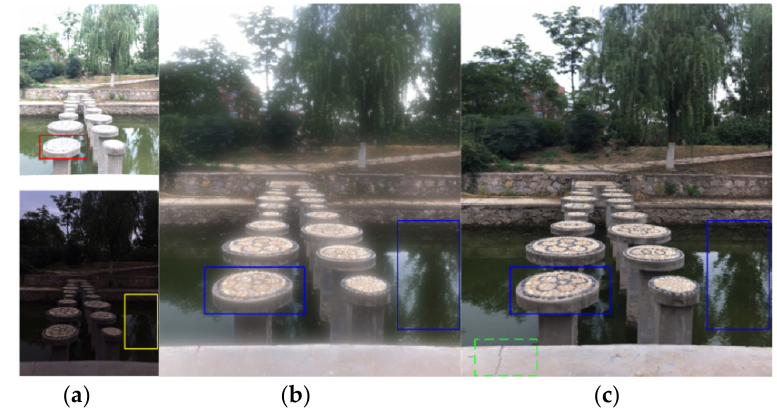
Figure 13. The fusion results of extreme-exposure image sequence. ( a ) The over- and under-exposed raw image sequence. ( b ) JPEG fusion result using our method. ( c ) Raw fusion result. Table 4. The results analysis of the extreme-exposure